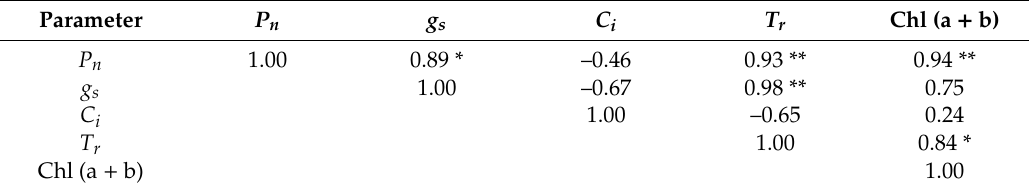
Table 3. Correlation matrix between the chlorophyll index and photosynthetic parameters of drip irrigation rice where * indicates significance at p < 0.05 and ** indicates significance at p < 0.01, sample size (N = 24). The maize transpiration rate ( T r ), photosynthetic rate ( P n ), stomatal